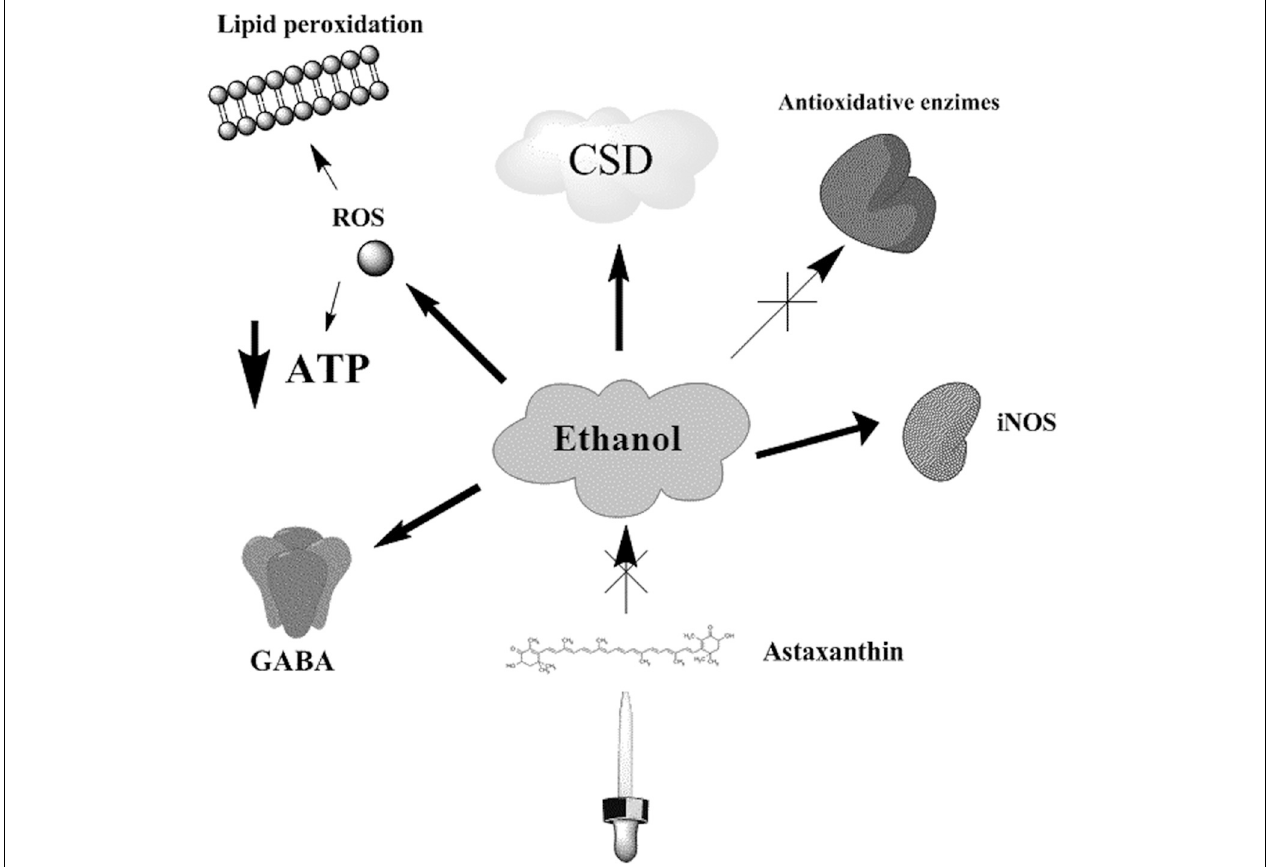
FIGURE 1 | Ethanol effects on CSD related processes. Ethanol administration induces the inhibition of Na + -K + -ATPase pump, depleting the ATP contents of the cell, and causing the generation of ROS and lipid peroxidation. Both chronic and acute administration of ethanol has impairing effects in CSD velocities, which in turn may reflect important alterations on